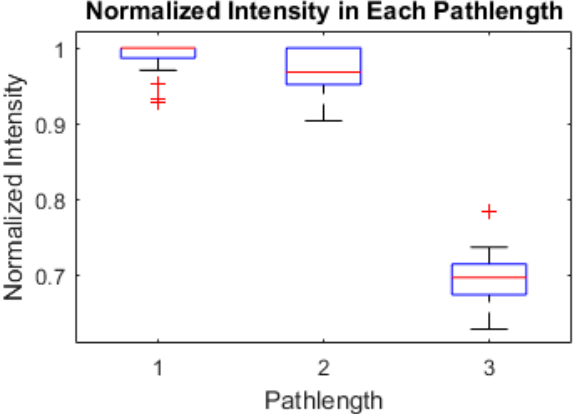
Figure 13. Distribution of normalized intensity of each pathlength is shown for 32 mouse retinal images. The mean normalized intensity was 0.99 for Pathlength 1, 0.97 for Pathlength 2, and 0.69 for Pathlength 3.